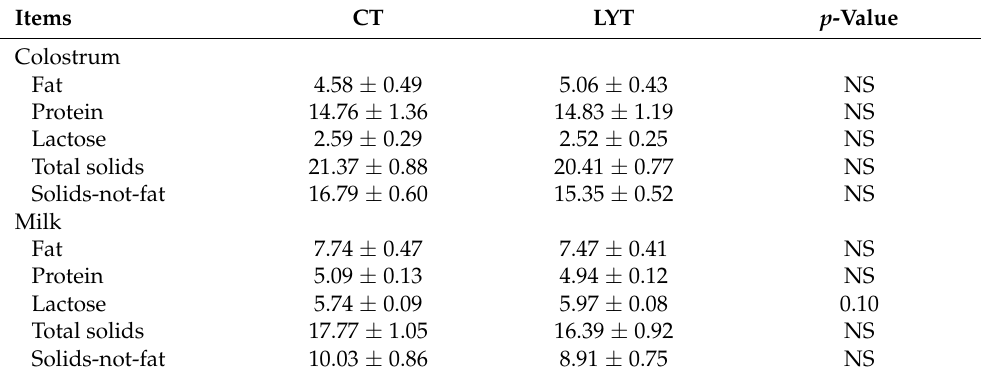
Table 6. The effect of live yeast supplementation during middle–late gestation and lactation on the compositions of colostrum and milk (%).